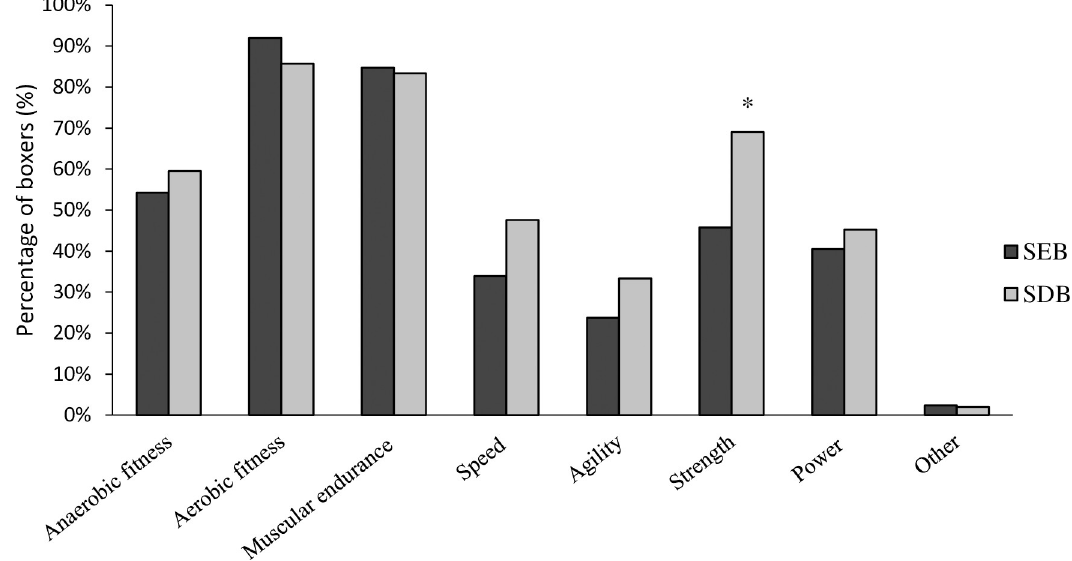
Fig 1. Percentage of boxers who perceive circuit training improves specific physical fitness attributes. � denotes significant association between competitor level and perception of physical fitness to circuit training (P � 0.005).